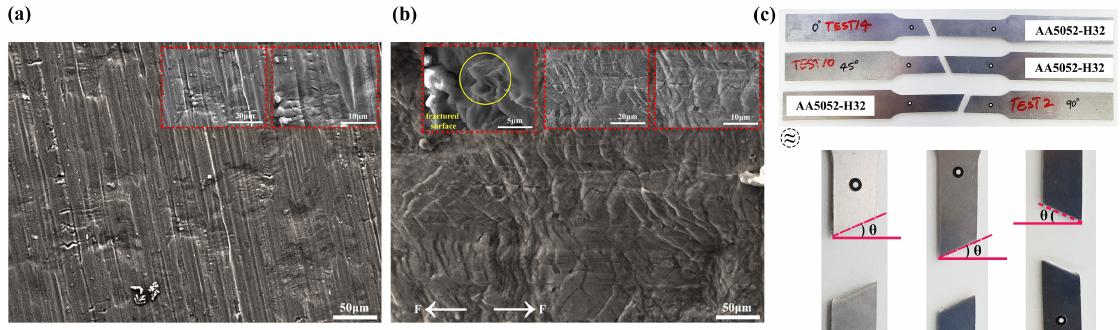
Figure 1. Field emission scanning electron microscopy (FESEM) analysis ( a ) Microstructure observation at initial state; ( b ) Microstructure observation after fracture; ( c ) Tested samples.